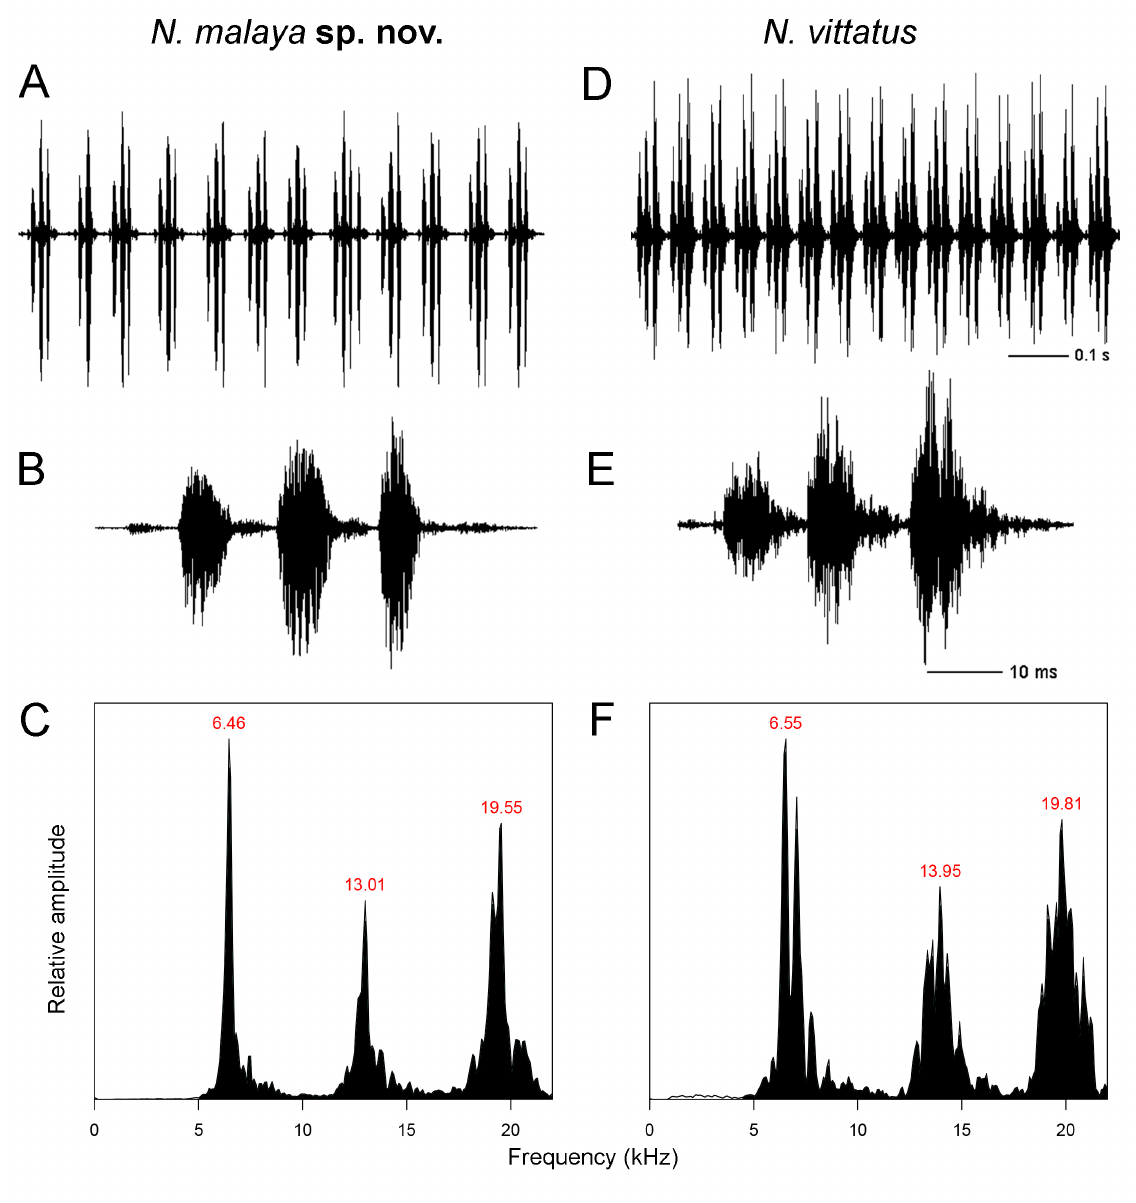
Fig. 25. Acoustics of Nisitrus malaya Robillard & Tan sp. nov. (A–C) and N. vittatus (Haan, 1844) (D–F). A, D . Series of echemes. B, F. One echeme. C, F . Spectral plot of one